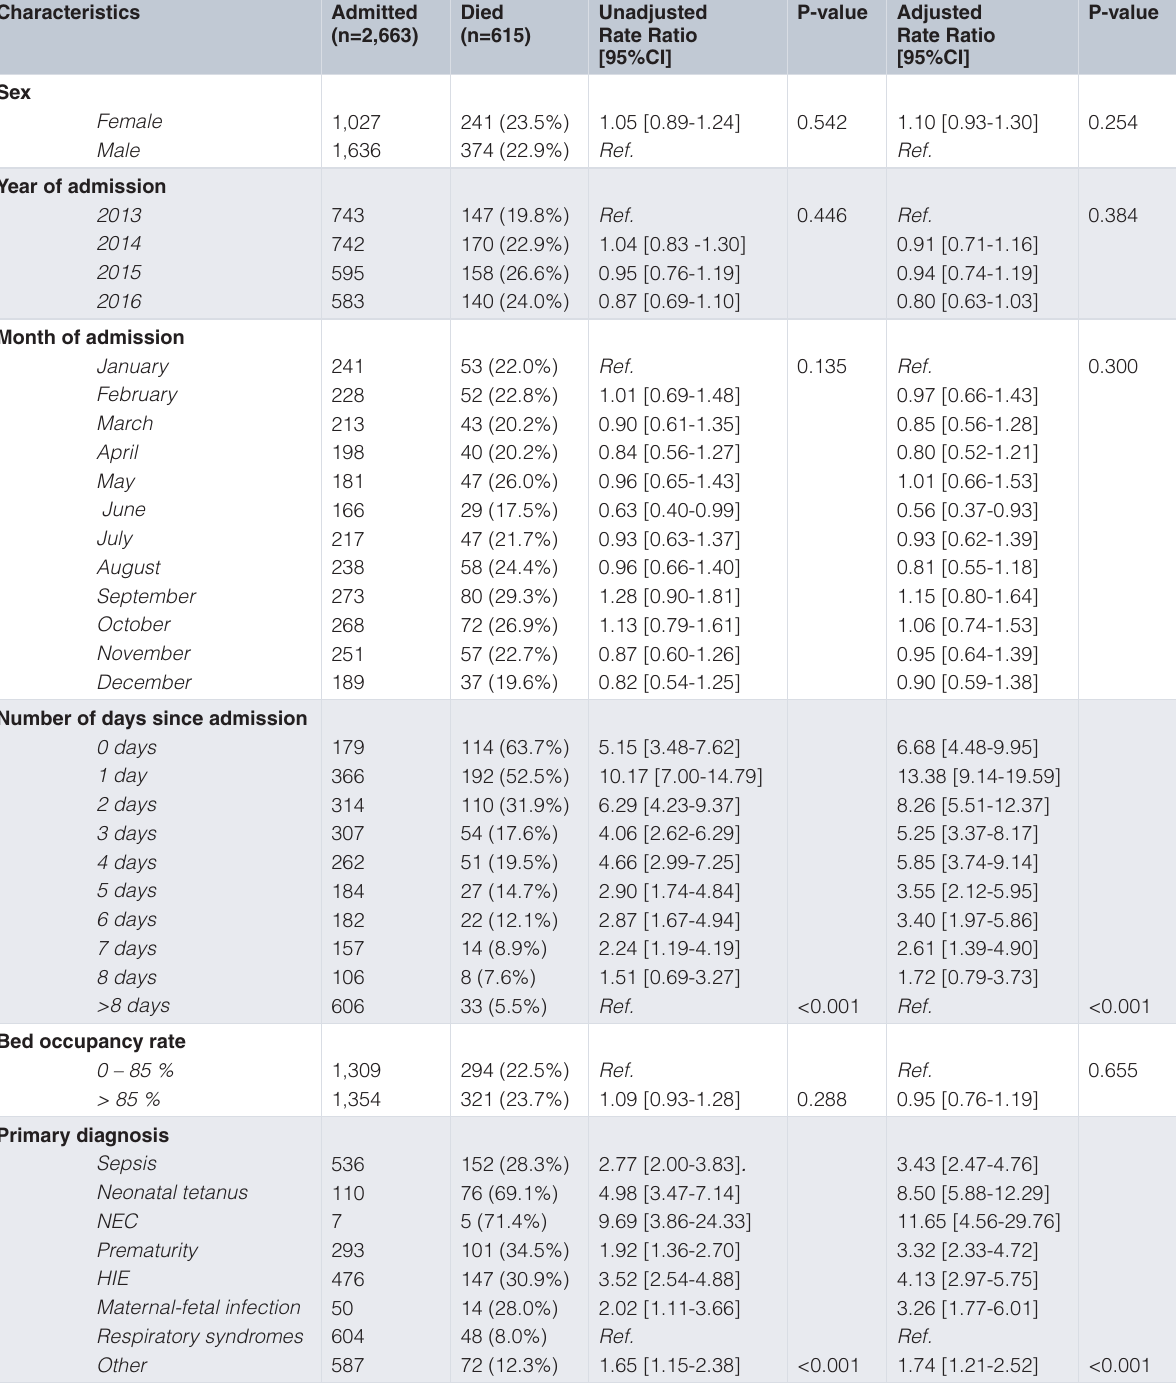
Table 3. Patient characteristics and analysis results of the infants (<7 months) who were admitted between 2013 and 2016 in the Inpatient Department (IPD) of Dera Murad Jamali (DMJ).